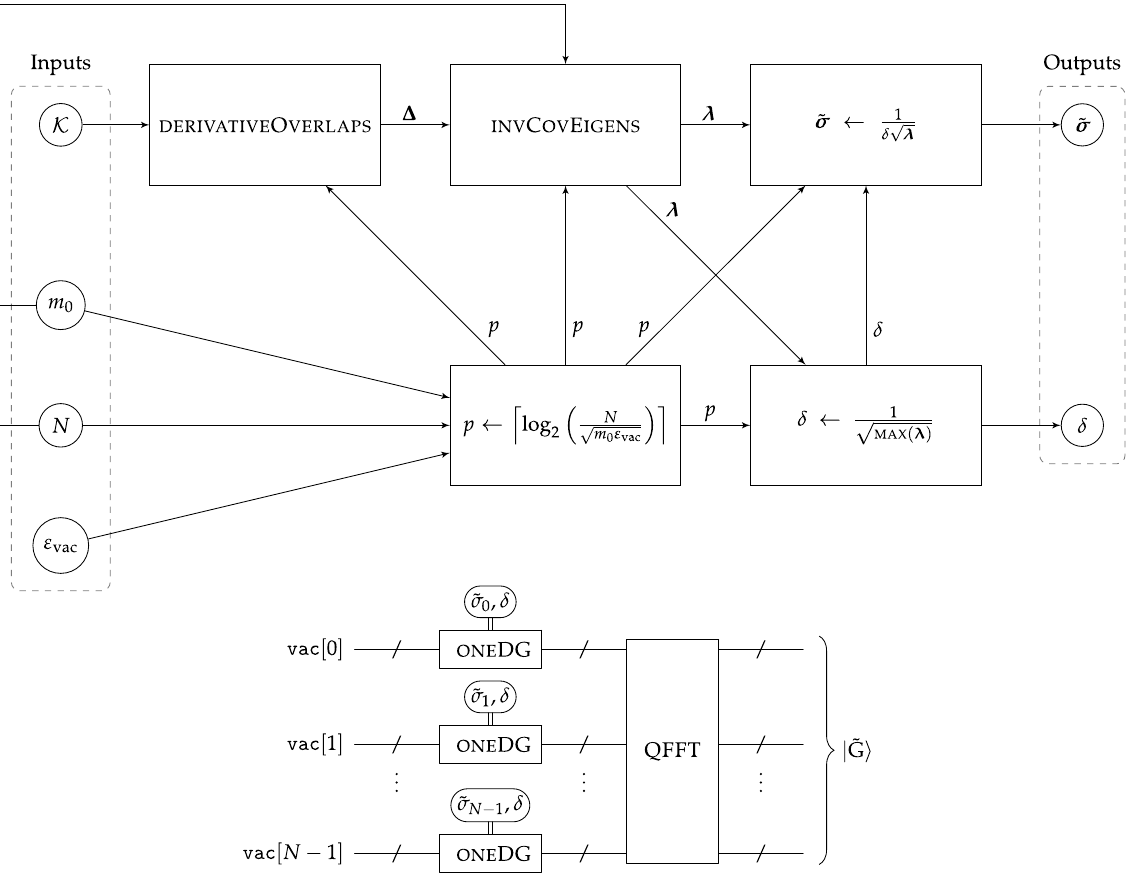
FIG. 6. Description of Fourier-based algorithm for ground-state generation. Top: classical preprocessing. Inputs: wavelet index K , mass m 0 , number of modes N in the discretized QFT, and error tolerance ε vac for the output state. Each box represents a process; incoming arrows identify the inputs, and outgoing arrows identify the outputs of the process. Outputs: standard deviation ˜ σ of the approximate one-dimensional Gaussian states and lattice spacing δ . Outputs of intermediate processes: working precision p , second- order derivative overlaps (cid:6) and eigenvalues λ of the ground-state ICM. Bottom: quantum routine. Double lines indicate classical inputs to the quantum routine. vac is a quantum register with N cells, and each cell comprises p qubits; ̸ represents multiple qubits. Each ONEDG accepts δ and one component of ˜ σ as classical inputs and generates an approximate 1DG state corresponding to these inputs on once cell of vac . The quantum fast Fourier transform ( QFFT ) acts collectively on the set of approximate 1DG states and ˜ transforms them into the approximate ground state | G (cid:14)